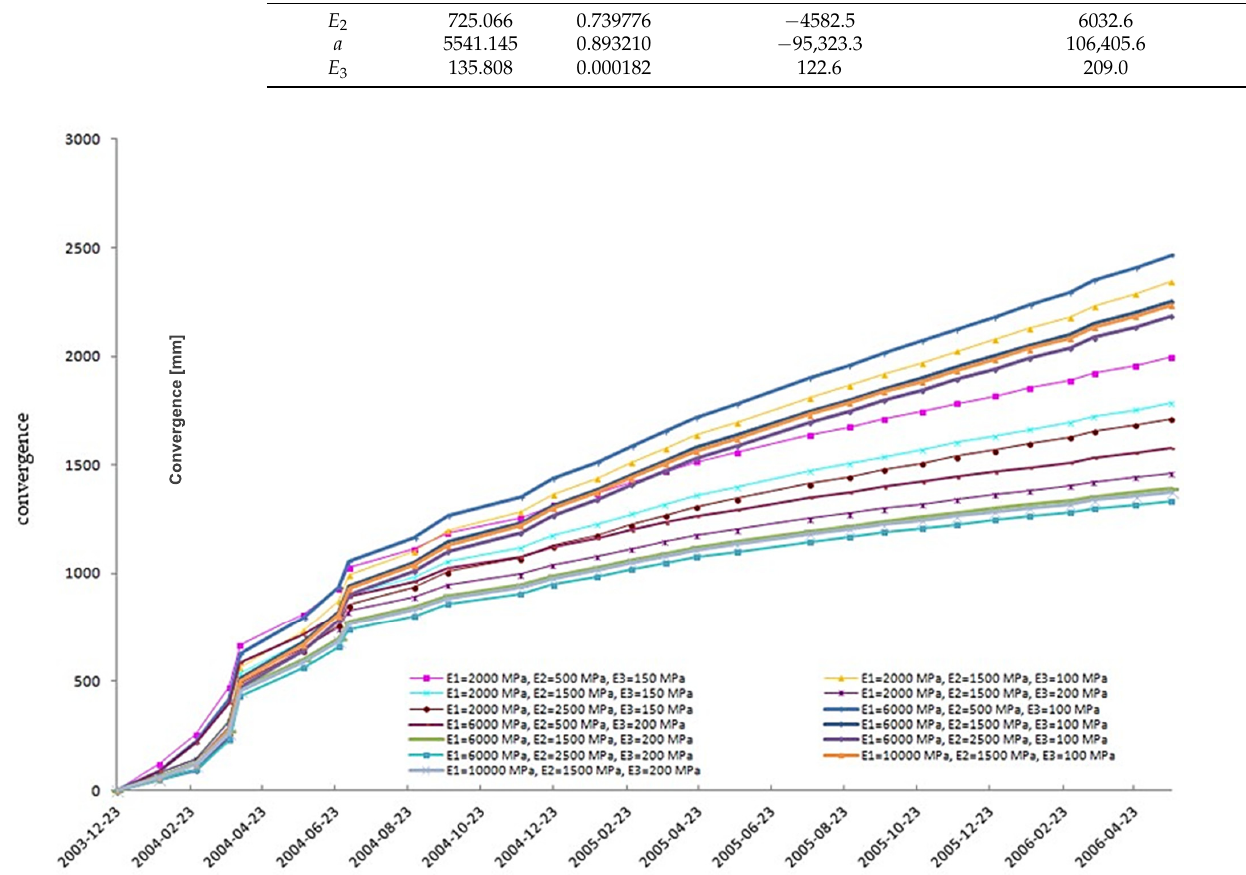
Figure 9. Chart of convergence determined numerically for chosen excavation in D-IE mining field for different combinations of parameter values assumed for pillars.